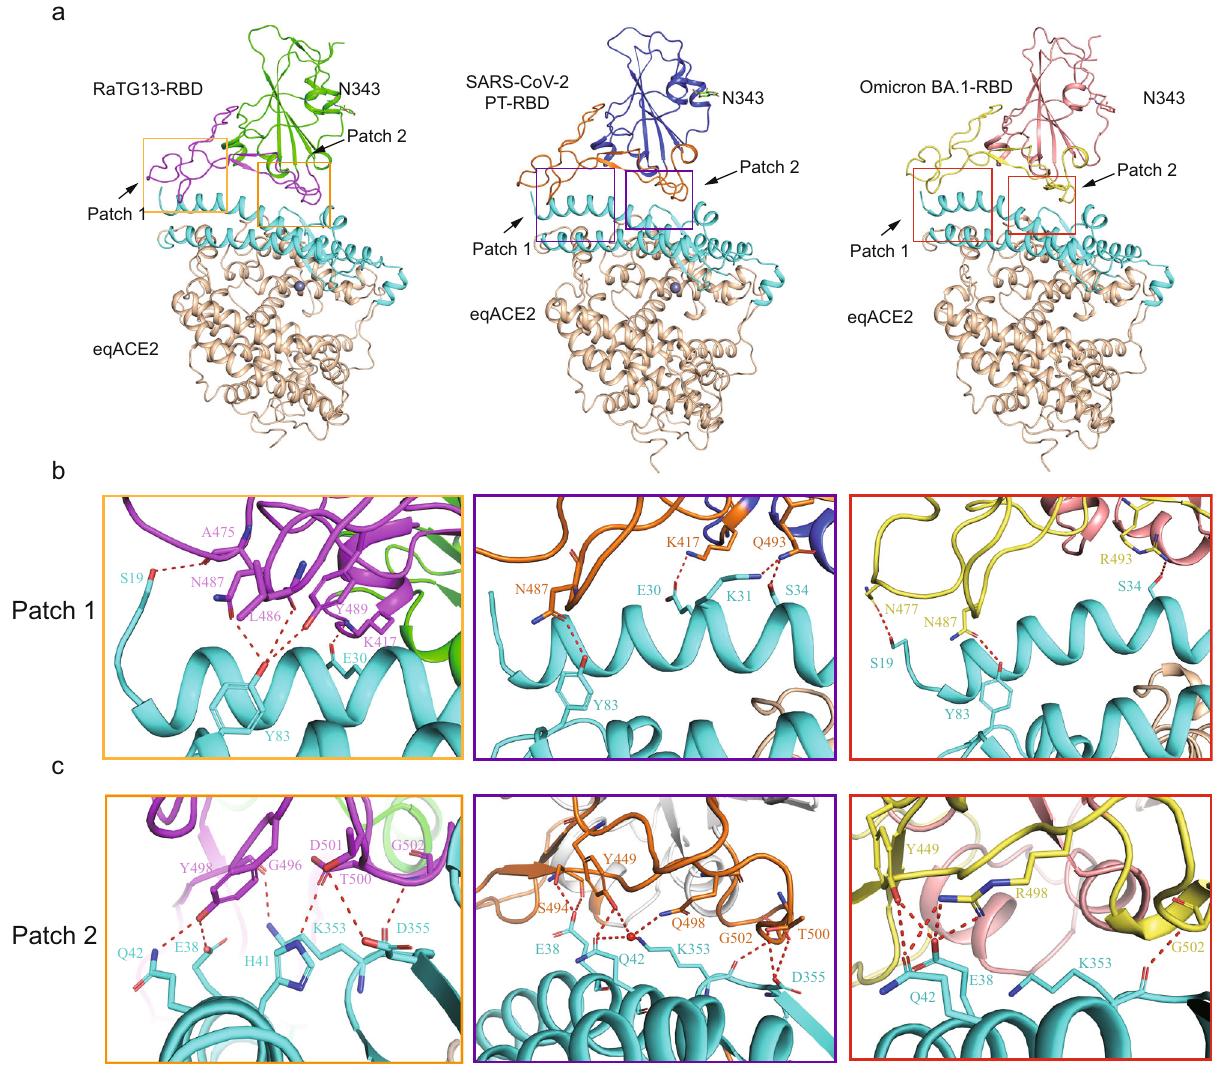
Fig. 2 Overall architecture of the eqACE2/RaTG13-RBD, eqACE2/SARS-COV-2 PT-RBD and eqACE2/Omicron BA.1-RBD complexes. a Overall structure of the eqACE2/RaTG13-RBD, eqACE2/SARS-COV-2 PT-RBD and eqACE2/Omicron BA.1-RBD complexes. Boxes indicate the interaction patches. b , c Detailed interaction of the three complexes in Patch 1 ( b ) and Patch 2 ( c ). The complex structure is shown as cartoon and residues involved in the polar interaction are labeled, and H-bonds are shown as red dotted lines with a cutoff of 3.5